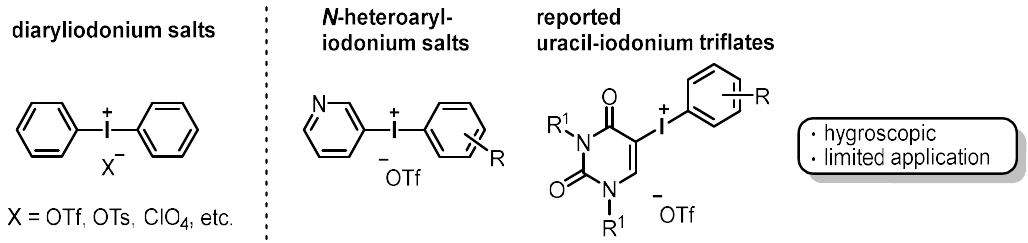
Figure 1. Conventional diaryliodonium(III) salts and their new heterocyclic series.